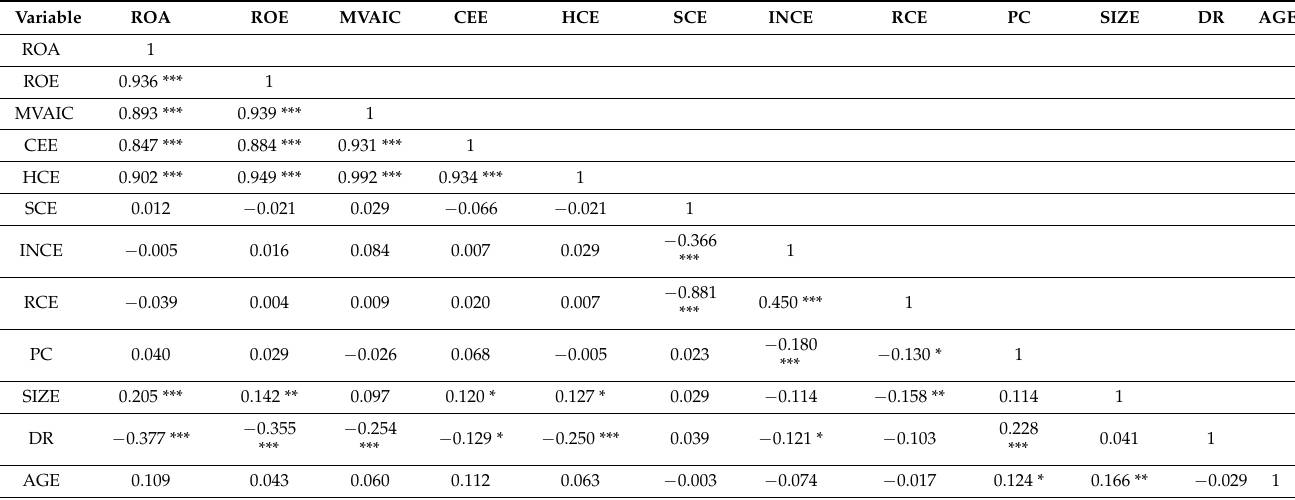
Table 7. Correlation analysis of the MVAIC